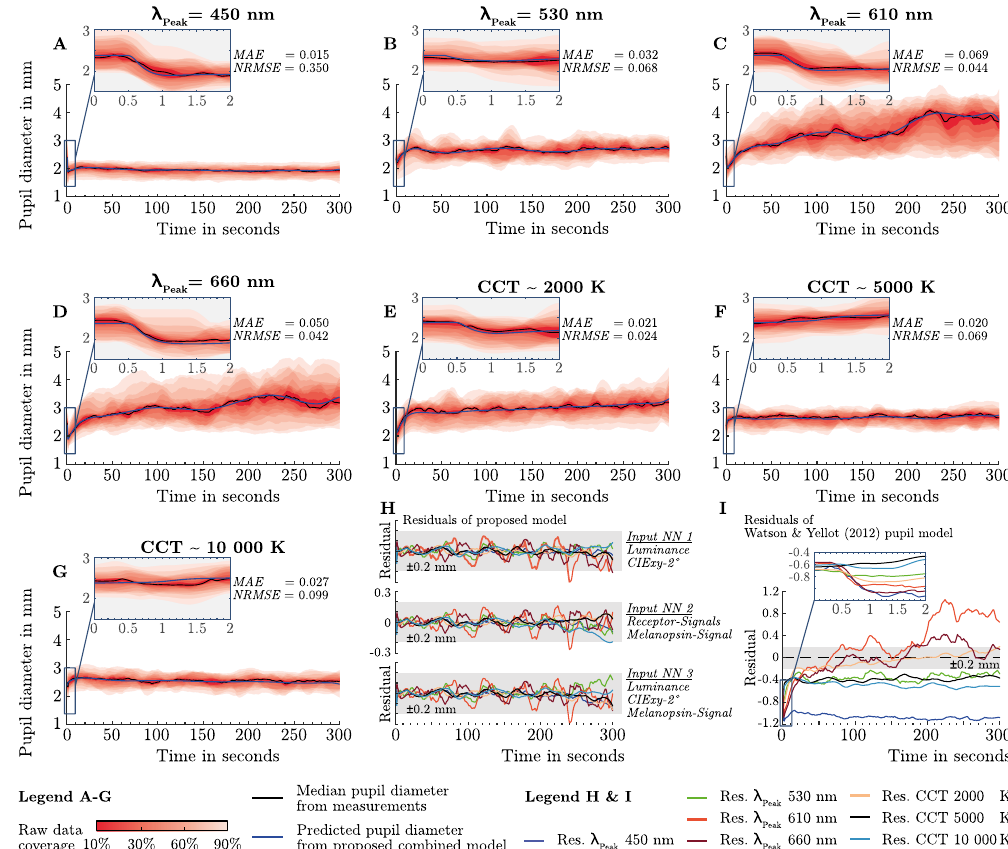
Figure 4. Results of the trained combined model approach with the intersubject dataset. ( A–G ) The measured median pupil diameter is plotted with the percentiles as a shaded area. The predicted reconstructed pupil diameter of our proposed model concept is drawn as a blue line for comparison. The neural network variant one, with the luminance and the CIExy-2° chromaticity coordinates, was used to predict the model parameters. ( H ) Calculated residuals from the measured median pupil diameter for each lighting condition. The residuals were calculated by running the whole model with different neural network variants to predict the model parameters for the phasic and tonic function. ( I ) Calculated residuals from the Watson and Yellot model for each light condition compared to the measured median pupil